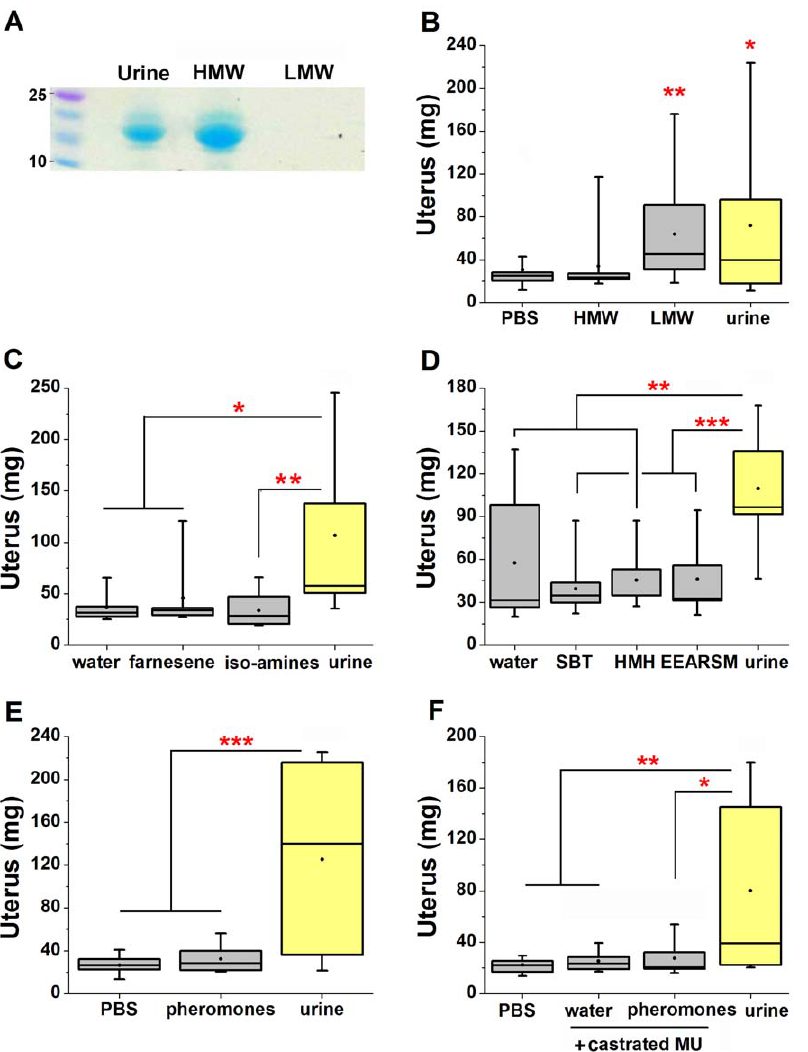
Figure 2. Analysis of pheromones previously identified to accelerate puberty. ( A ) SDS-PAGE of fractionation of urine by molecular mass; high molecular weight retentate (HMW . 3 kDa,), low molecular weight (LMW , 3 kDa). kDa size marker on left. ( B ) Exposure to LMW urine fractions increases uterine mass (Dunnett’s). (End body masses are not significantly different, p=0.237). Averages of body mass (g): PBS, 16.78; HMW, 16.46; LMW, 16.64; urine, 16.8. n=10–19 per group. ( C ) b -farnesene (250ppm) and isoamyl- and isobutylamine (50 mM each) presented in water do not increase uterine weight (Tukey’s HSD). (End body masses are not significantly different, p=0.348). Averages of body mass (g): water, 17.43; b - farnesene, 17.71; iso-amines, 17.41; urine, 18.03. n=7–8 per group. ( D ) SBT (2.6 ppm), HMH (2000 ppm), and EEARSM (0.5 mg/ml) presented in water or PBS do not significantly increase uterine mass (Tukey’s HSD). (End body masses are not significantly different, p=0.808). Averages of body mass (g): water, 17.25; SBT, 17.56; HMH, 17.26; EEARSM, 17.24; urine, 17.62. n=10 per group. ( E ) A blend of known pheromones ( b -farnesene, IAA, IBA, HMH, SBT, and EEARSM) in PBS does not significantly increase uterine mass (Tukey’s HSD). (End body masses are not significantly different, p=0.20). Averages of body mass (g): PBS, 16.79; pheromones, 17.05; urine, 17.36. n=13 per group. ( F ) Neither water nor a blend of known pheromones ( b - farnesene, HMH, SBT, and EEARSM) added to urine from castrated males ( + castrated MU) generates an increase in uterine mass (Tukey’s HSD). (End body masses are not significantly different, p=0.286). Averages of body mass (g): PBS, 16.81; castrate MU, 16.97; blend castrate MU, 17.03; urine, 17.45. n=8–10 per group. *p , 0.05, **p , 0.01, ***p , 0.001.